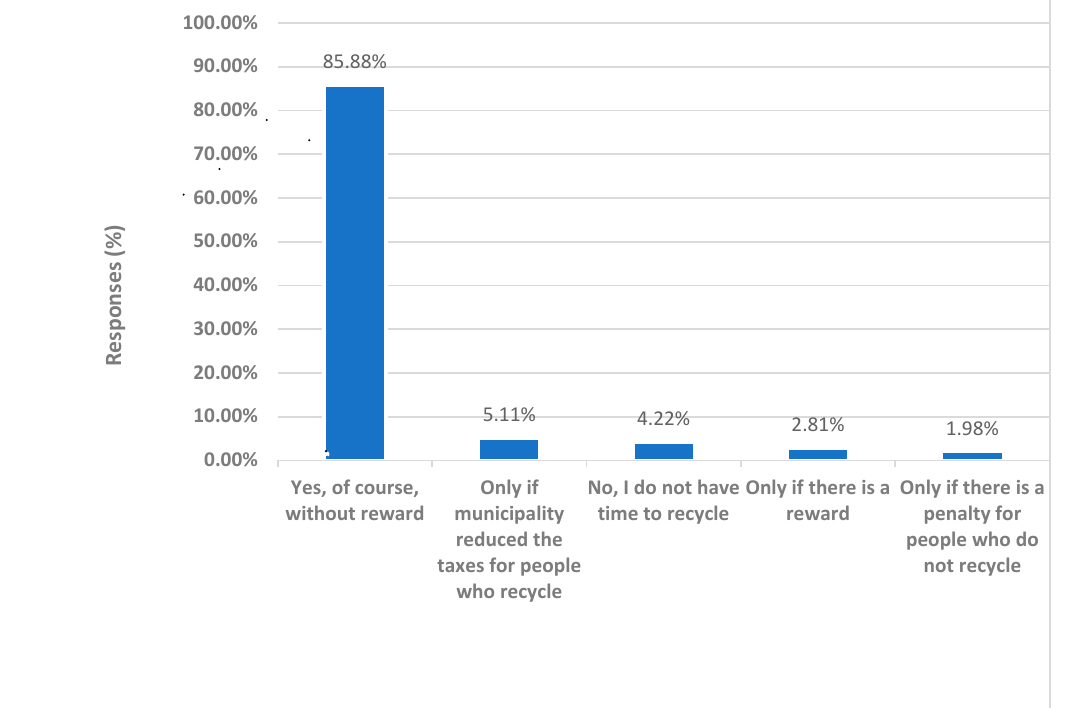
Figure 9. Responses to the question, “Would you recycle your food waste in organic material recycle bins?”